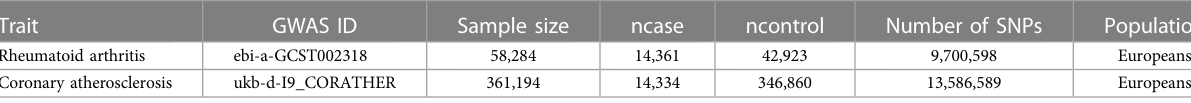
TABLE 1 Description of data used for the two phenotypes.